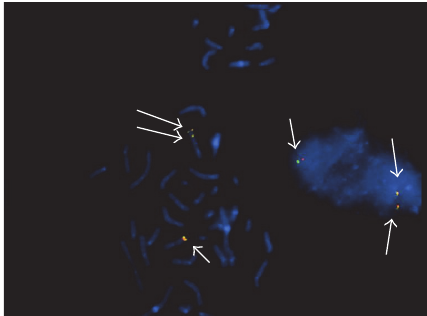
Figure 1: Ultrasound image. Ultrasound image in which we observe stomach and liver in the chest cavity next to four-chamber view of the heart and left lung’s volume reduced.